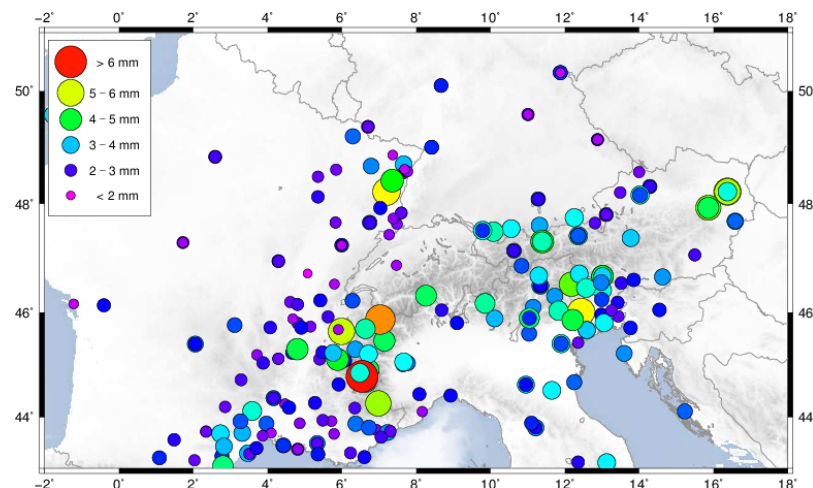
Figure 6. Mean RMS values of the station position time series for the period January 2004 to May 2016.